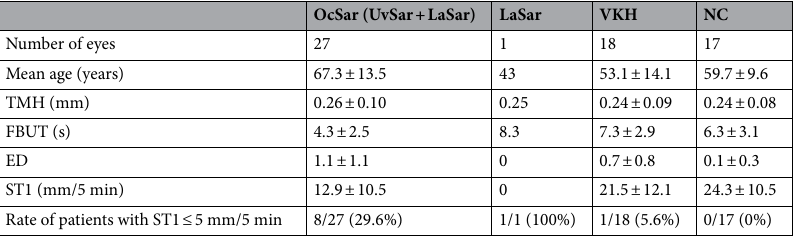
OcSar vs. VKH OcSar vs. NC VKH vs.